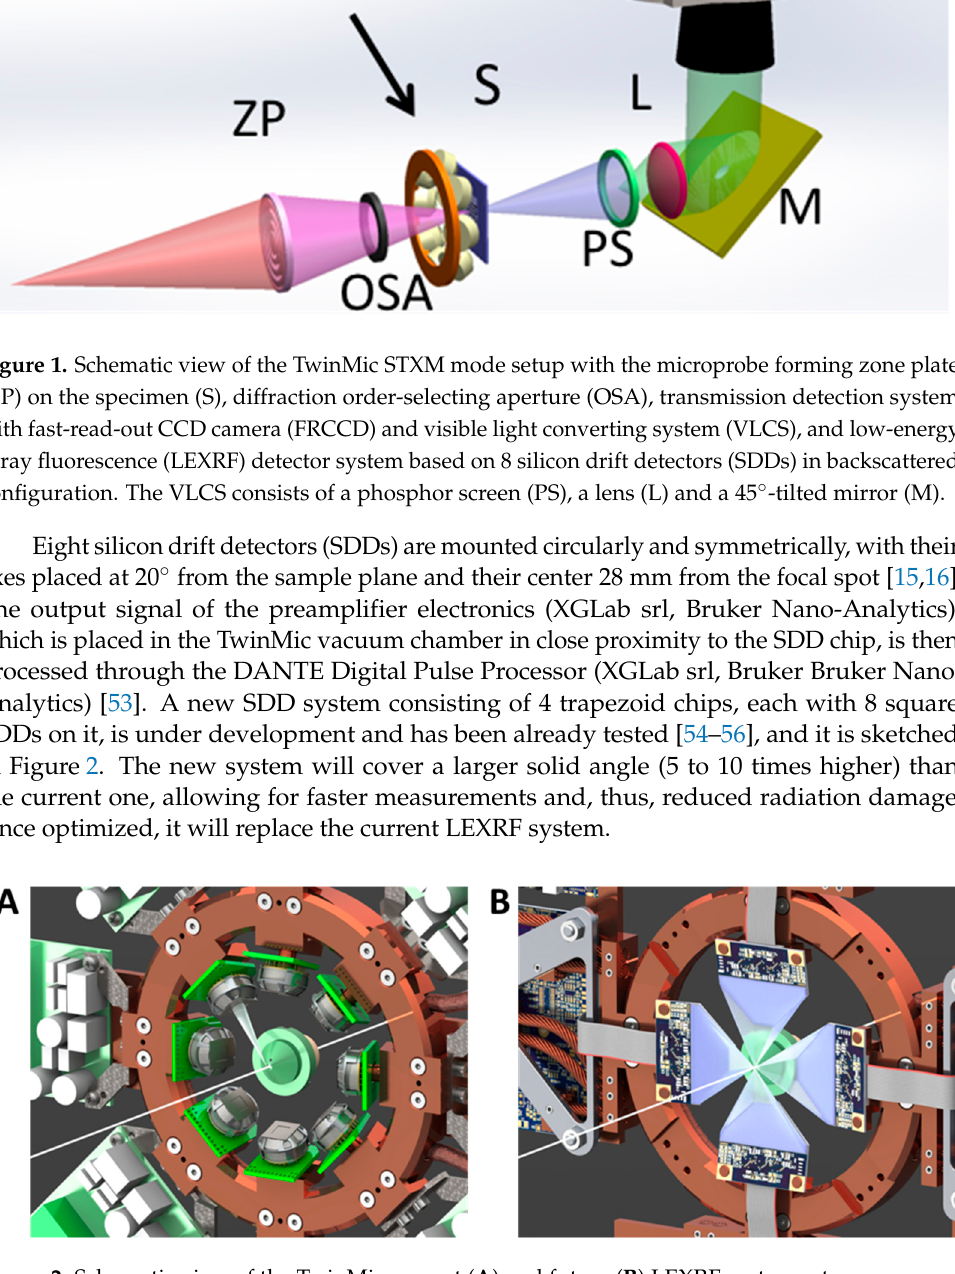
Figure 2. Schematic view of the TwinMic current ( A ) and future ( B ) LEXRF system setup.